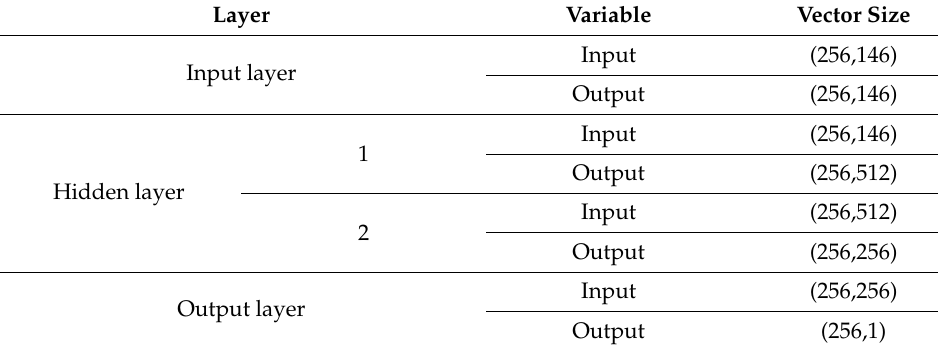
Table 6. Structure of MLP neural